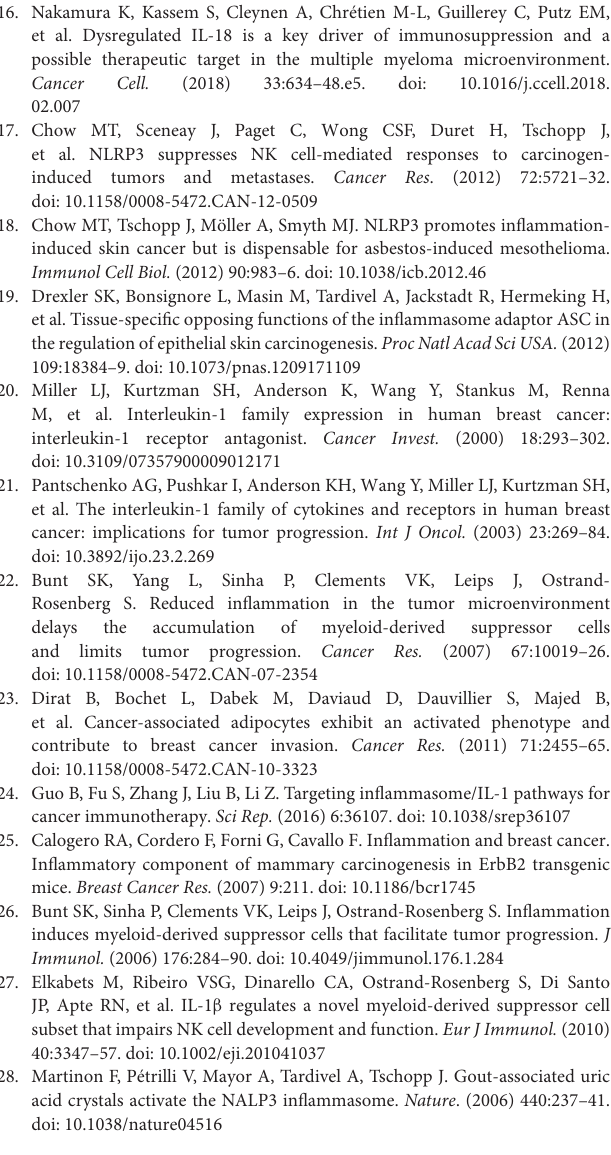
Supplementary Figure 3 | Cytokine measurements in tumor cell supernatants of WT or caspase-1 KO mice by Luminex technology. Supernatants from tumor dilacerations of WT ( N = 8) and caspase-1 KO ( N = 8) mice were analyzed by Luminex assay for CCL5 IL-1 β , CCL3, IL-33, KC, and FGF-b. Data represent mean ± SD ( p from unpaired t -test). Supplementary Figure 4 | NK cells control tumor growth and are more activated in caspase-1 KO mice. (A) Cytometric profiles of data shown in Figure 6F . Cell suspensions from digested tumors of the indicated mouse genotype were cultured in the presence of cytokines (IL-12/IL-18), antibodies (NKp46, Ly49D, NKG2D), or tumor cells (YAC-1, 4T1) and NK cell IFN- γ production was measured by flow cytometry. (B) Comparison of IFN- γ -positive NK cells from tumor of WT and Caspase-1 KO mice exposed or not to 4T1 cells. Supplementary Table 1 | Inventory of fluorochrome conjugated-antibodies used for cytometry